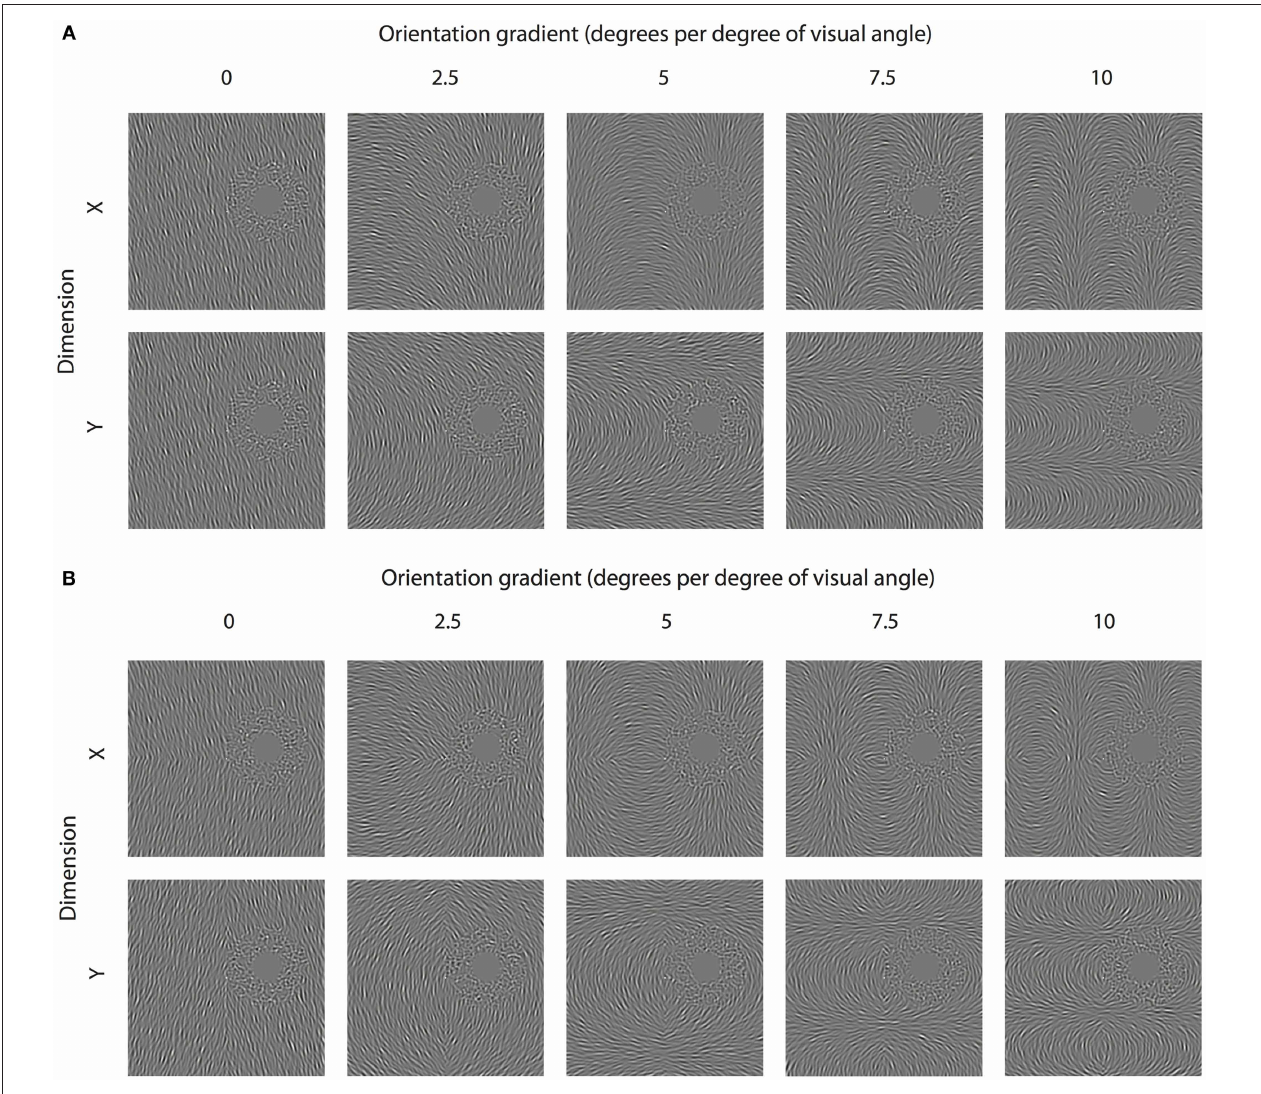
FIGURE 3 | Inducing spatially remote TAEs with orientation gradients. (A) Smoothly varying orientation textures are shown, where structure is defined by a linear change in orientation as a function of either the horizontal (x) or vertical position (y). In each stimulus, the underlying orientation gradient is anchored about the test location (center of noisy